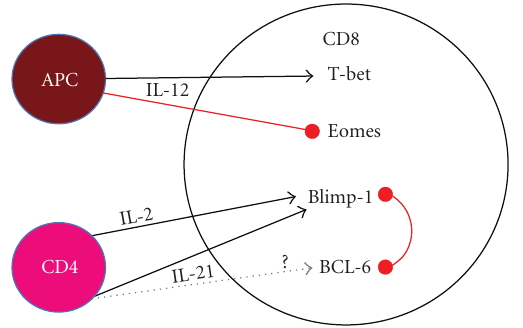
Figure 4: Regulation of transcription factors that impart CD8 T cell fate and function by external signaling. Black arrows indicate induction; red dots represent suppression. Blimp-1 and Bcl-6 are mutually repressive in CD8 T cells. IL-21 induces both Blimp-1 and Bcl-6 in B cells and is capable of inducing Blimp-1 in CD8 T cells. Induction of Bcl-6 in response to IL-21 in CD8 T cells has yet to be evaluated, as indicated by the dashed line with the question